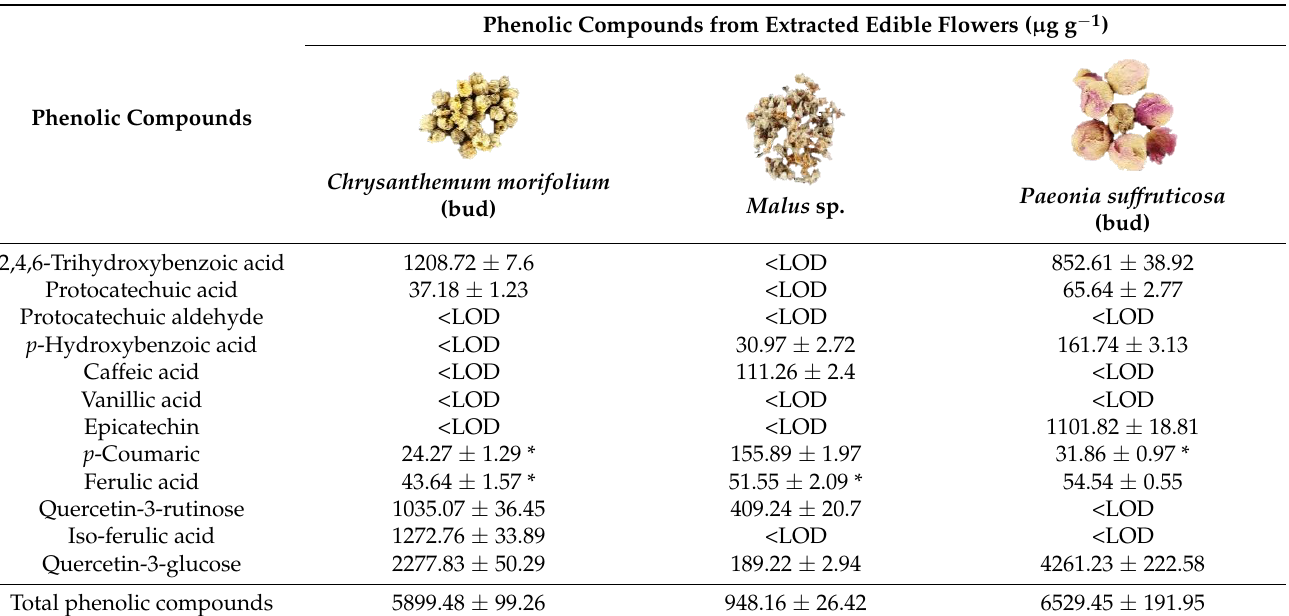
Table 4c. Individual phenolic compounds from different dried edible flowers ( continue)